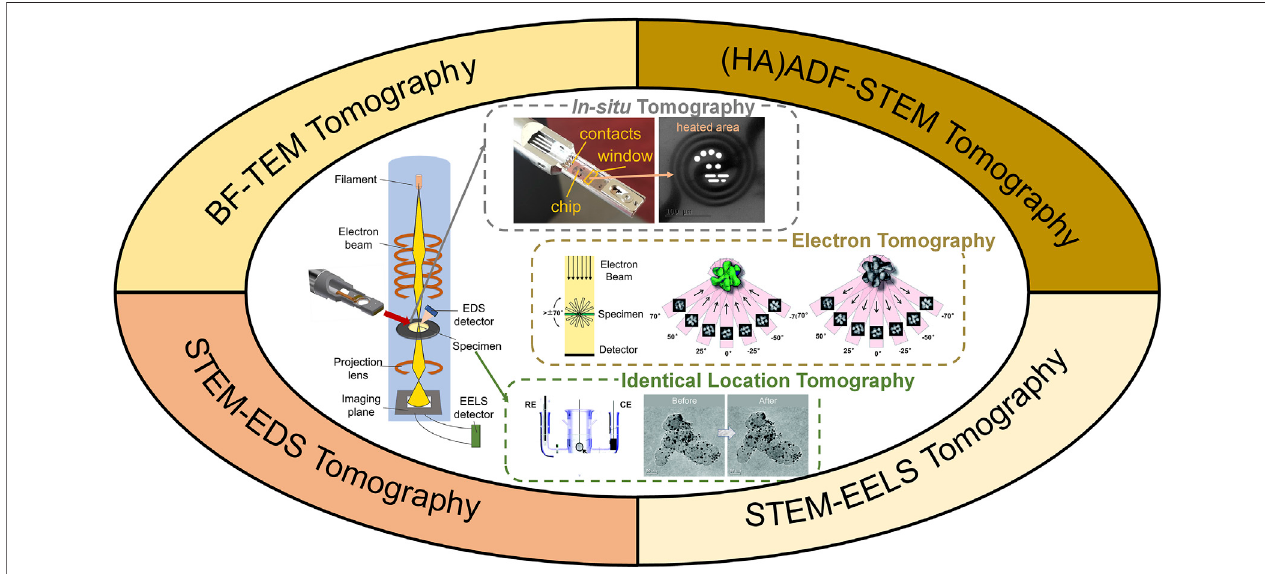
FIGURE 1 | Illustration of 3D electron tomography for electrocatalysts ’ characterization. WE, RE, CE are shorts for working electrode, refence electrode and counterelectrode,respectively.Illustrationof in-situ tomographywasphotographedfromaDENSSolution in-situ heatingholder.Illustrationsofelectrontomographyand identical location TEM tomography were reprinted with permission from (Yu et al., 2012; Bals et al., 2014). Copyright 2014, WILEY-VCH. Copyright 2012, American Chemical Society.